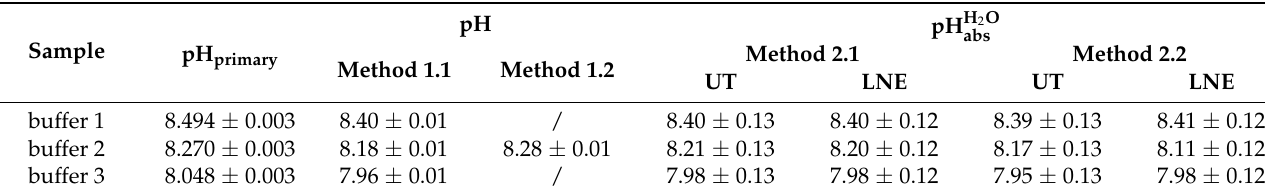
Table 4. Primary pH values assigned to the buffer solutions by the Harned method, pH and pH H 2 O Tris-Tris · HCl buffer solutions with different configurations of methods 1 and 2. pH primary and pH H 2 O with standard (k = 1) uncertainties, pH values with intermediate precision standard